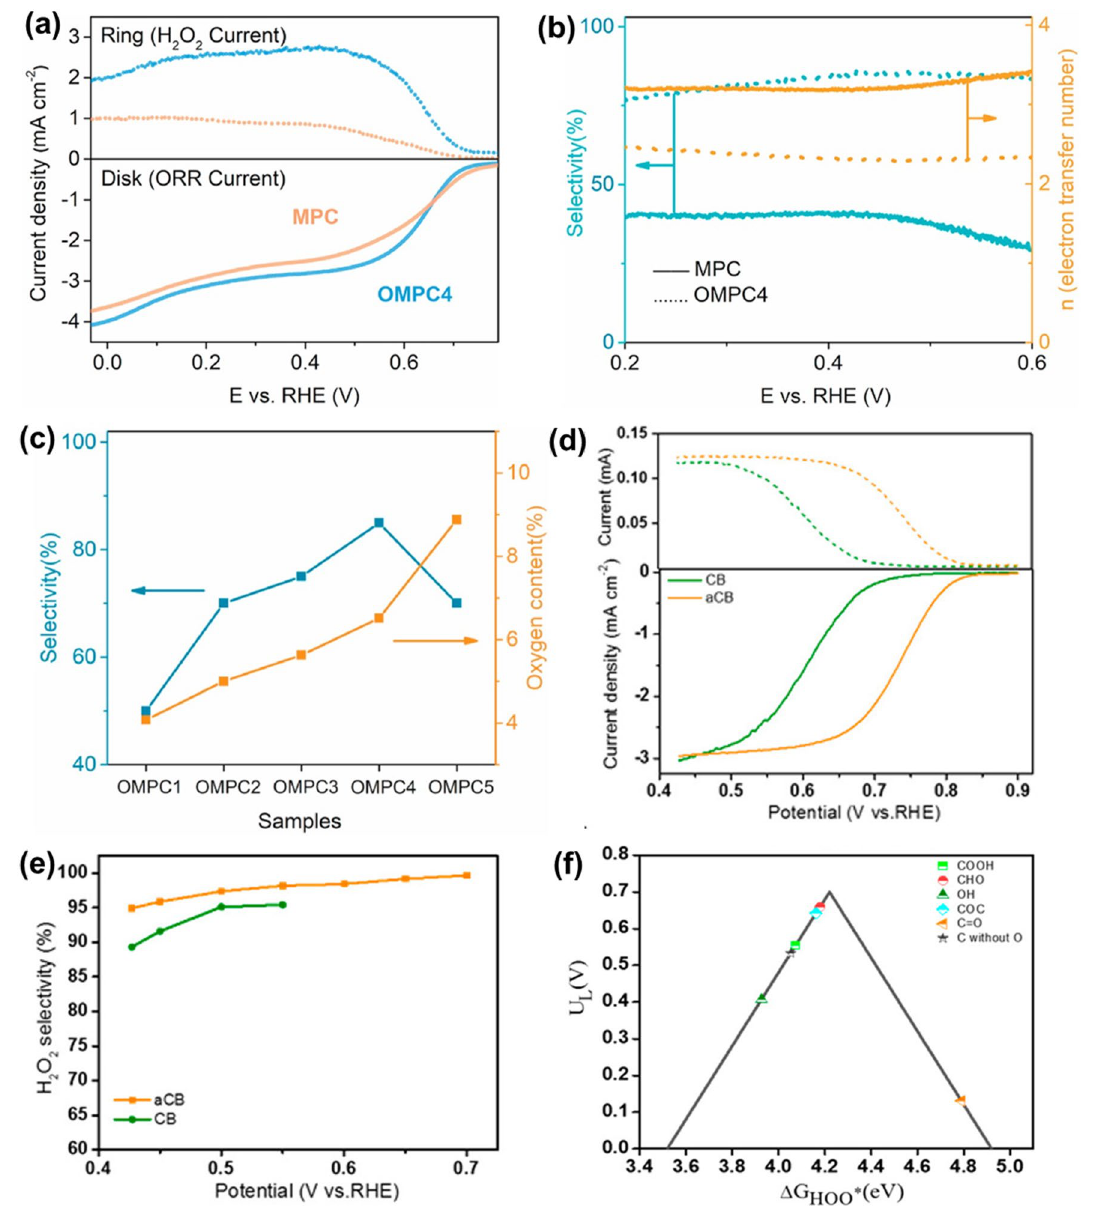
Fig. 15 a ORR performance, b selectivity and electron transfer number of OMPC4 and MPC in O 2 -saturated 0.1 M KOH. c Relationship between the selectivity and oxygen content of various OMPC-samples. Reproduced with permission from Ref. [220]. Copyright 2020 Elsevier. d ORR performance and e selectivity of aCB and CB in 0.1 M O 2 -saturated KOH. f Activity volcano plot of the 2e − ORR. Reproduced with per- mission from Ref. [222]. Copyright 2018 American Chemical